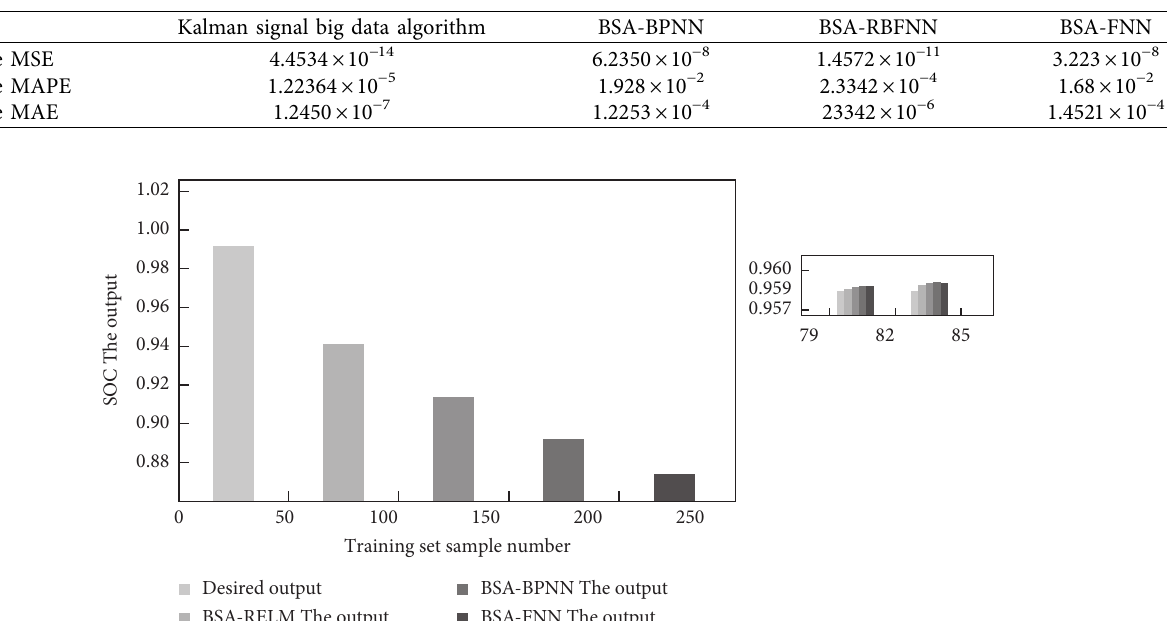
Table 2: Prediction errors of various networks.